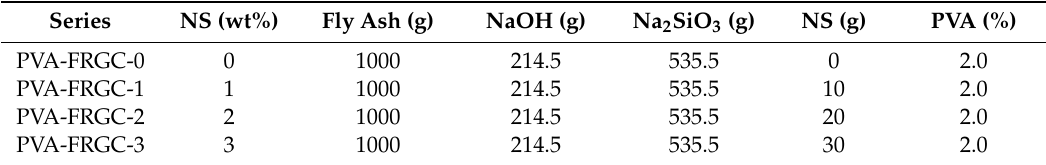
Table 3. Mix proportions of